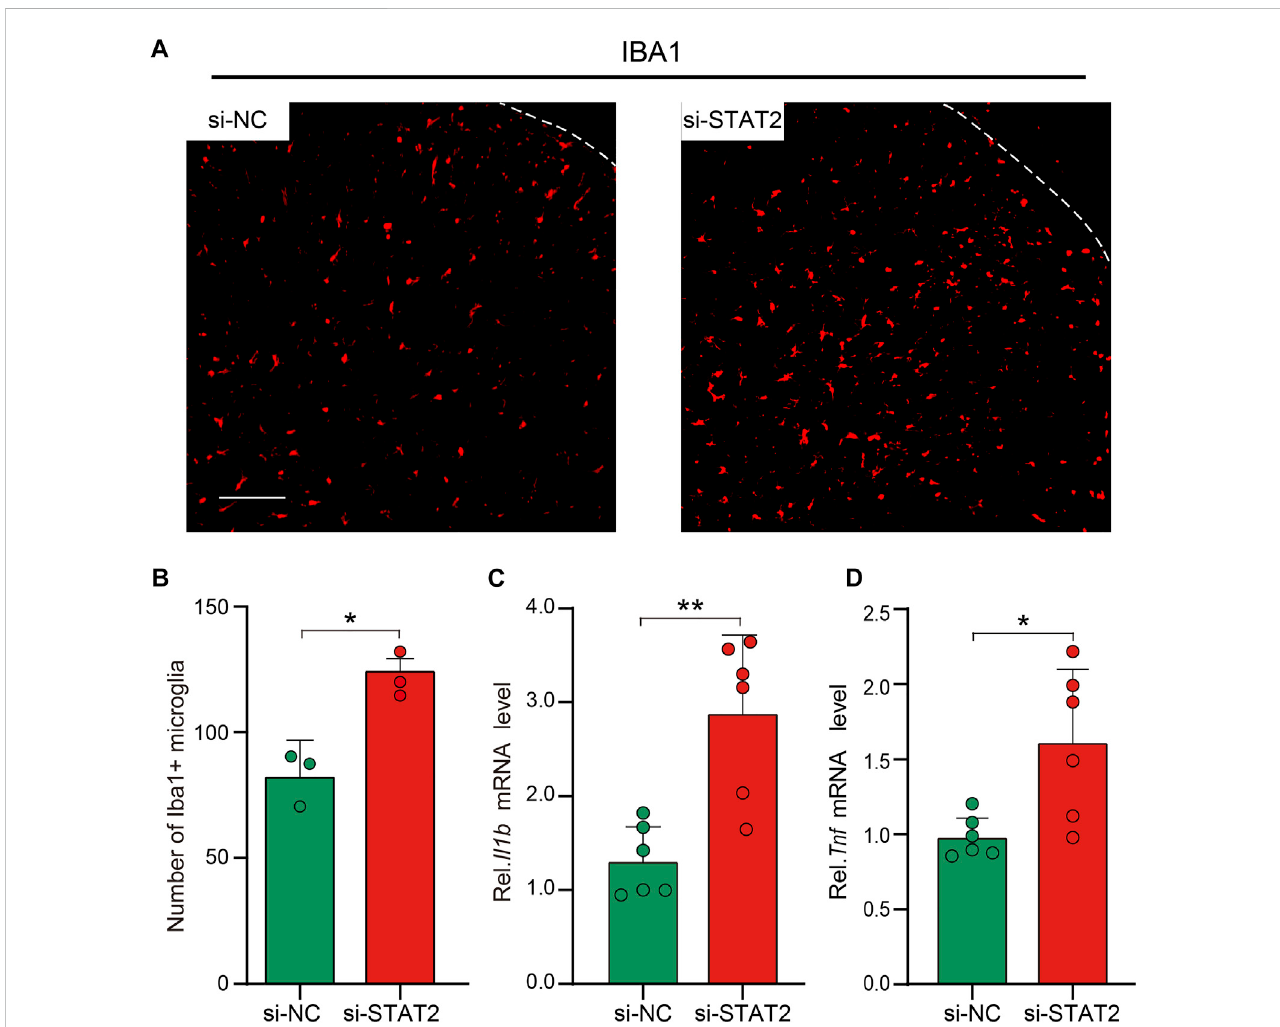
FIGURE 6 Downregulation of STAT2 promoted microglial activation and Tnf and Il1b expression. (A) Negative control (si-NC) rats had resting microglia with a rami fi ed morphology, whereas si-STAT2 rats had activated microglia with an amoeboid morphology. ( n = 3, scale bar = 100 µm). (B) si-STAT2 treatment increased thenumberofmicrogliainthespinal dorsalhorn(SDH)( n =3,* p < .05,Mann-Whitneytest). (C,D) Expression ofIl1bandTnfmRNAwassigni fi cantly increased in the SDH after intraspinal injection of si-STAT2 ( n = 6, ** p < .01, * p < .05, two-tailed unpaired Student ’ s